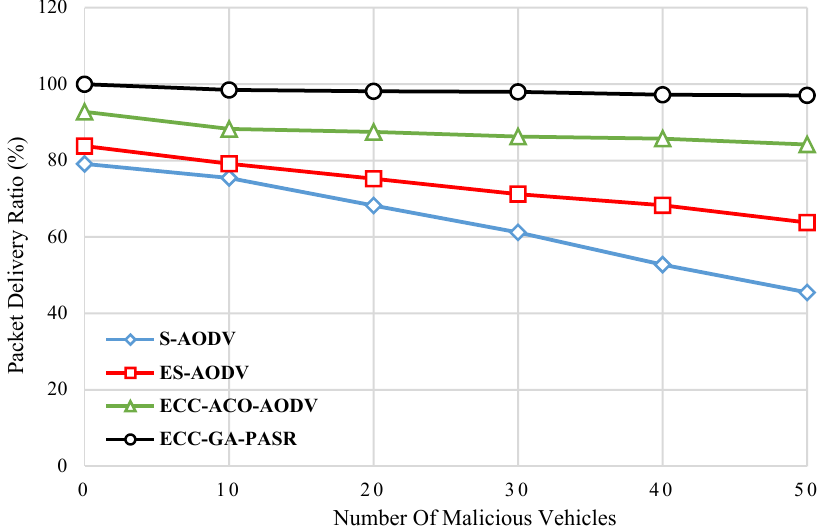
Figure 18. Packet Delivery Ratio Calculation based on number of malicious vehicles.